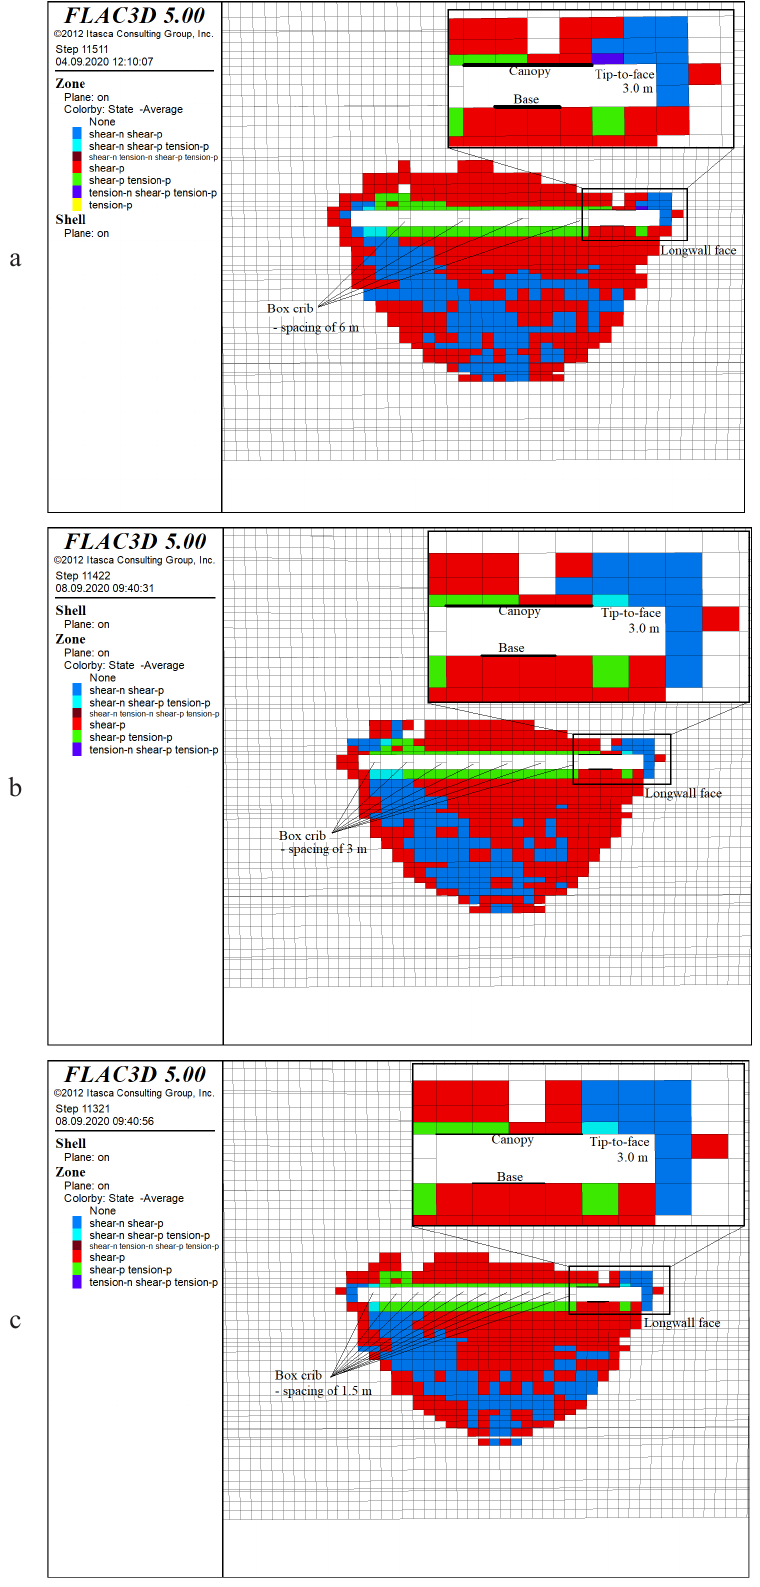
Figure 19: Plasticity around the longwall face with different spacing of the box crib: a) 6.0 m, b) 3.0 m and c) 1.5